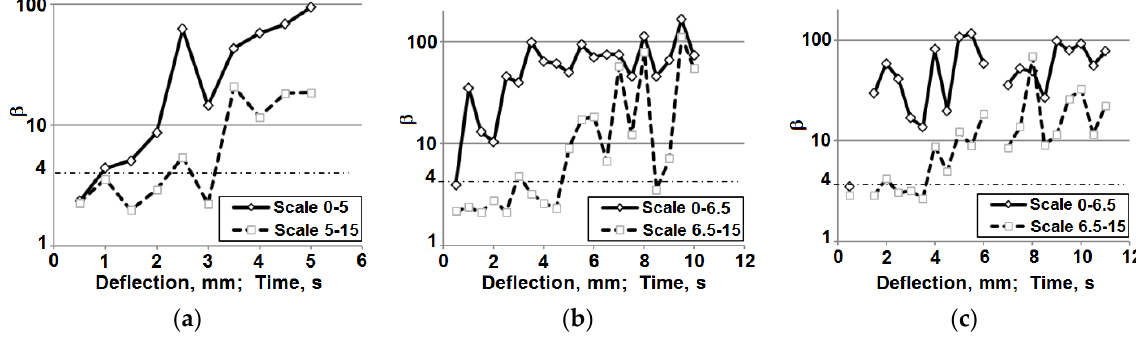
Figure 17. Kurtosis: ( a ) Classic laminate; ( b ) 3D laminate, direction W ; ( c ) 3D laminate, direction P .